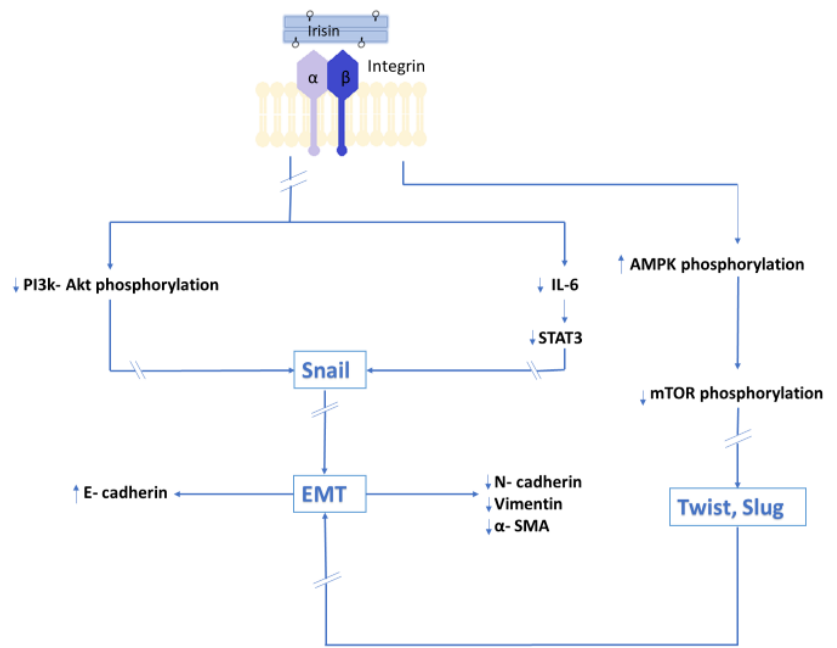
Figure 3. Irisin (Ir) inhibits PI3K/Akt signaling pathway and the transcription factor Snail, which is the major downregulator of E-cadherin gene expression. Ir reverses the effect of IL-6 by increasing E-cadherin expression. Ir has also an inhibitory effect on the STAT3 signaling pathway and transcription factor Snail, which are activated by IL-6 and are crucial for EMT. Ir increases the phosphorylation of AMPK and decreases the phosphorylation of the downstream molecule of AMPK signaling (mTOR pathway), which leads to the inhibition of the expression of transcription factors and the inhibition of EMT.